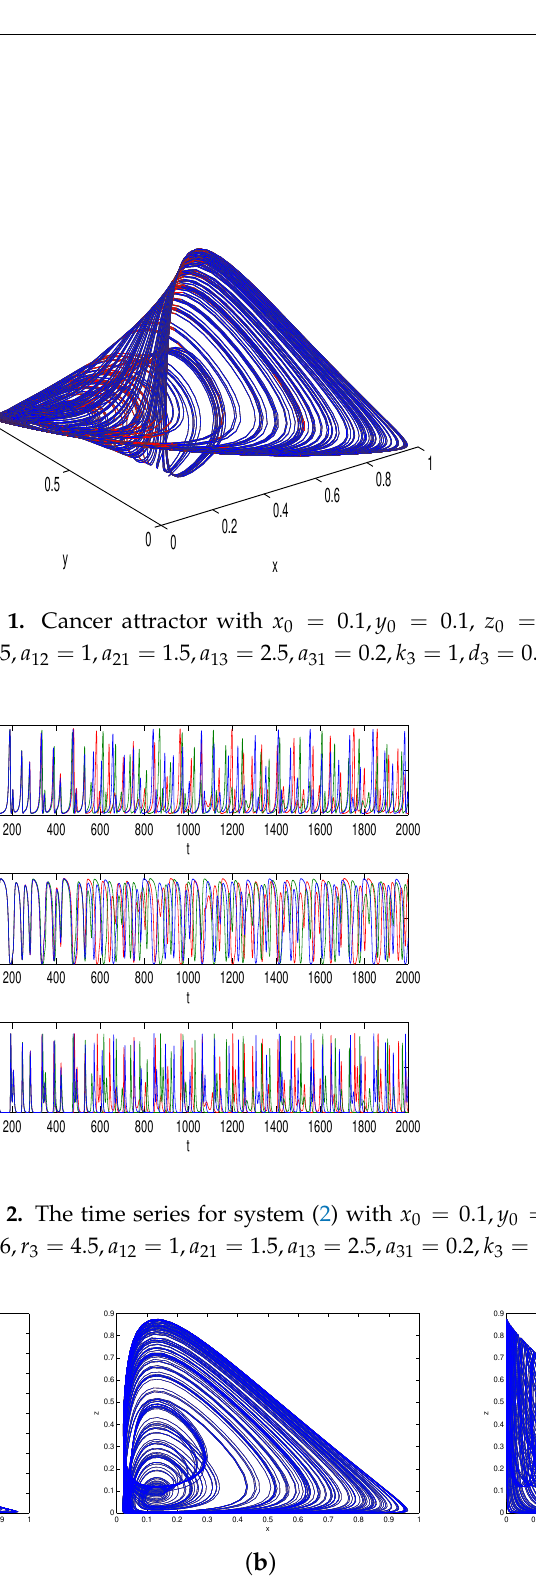
Figure 3. Two-dimensional projections of the phase portraits onto the X − Y by each variable, x , y , and z . ( a ) Normal cells : X = x . ( b ) Effector immune cells : X = y . ( c ) Tumor cells : X = z . The Lyapunov exponents of system (2) are computed to be λ 1 = 0.021909, λ 2 = − 0.00085097 and λ 3 = − 0.54025. The Lyapunov dimension for system (2) is (cid:39) D L = 2 + λ 1 + λ 2 λ 3